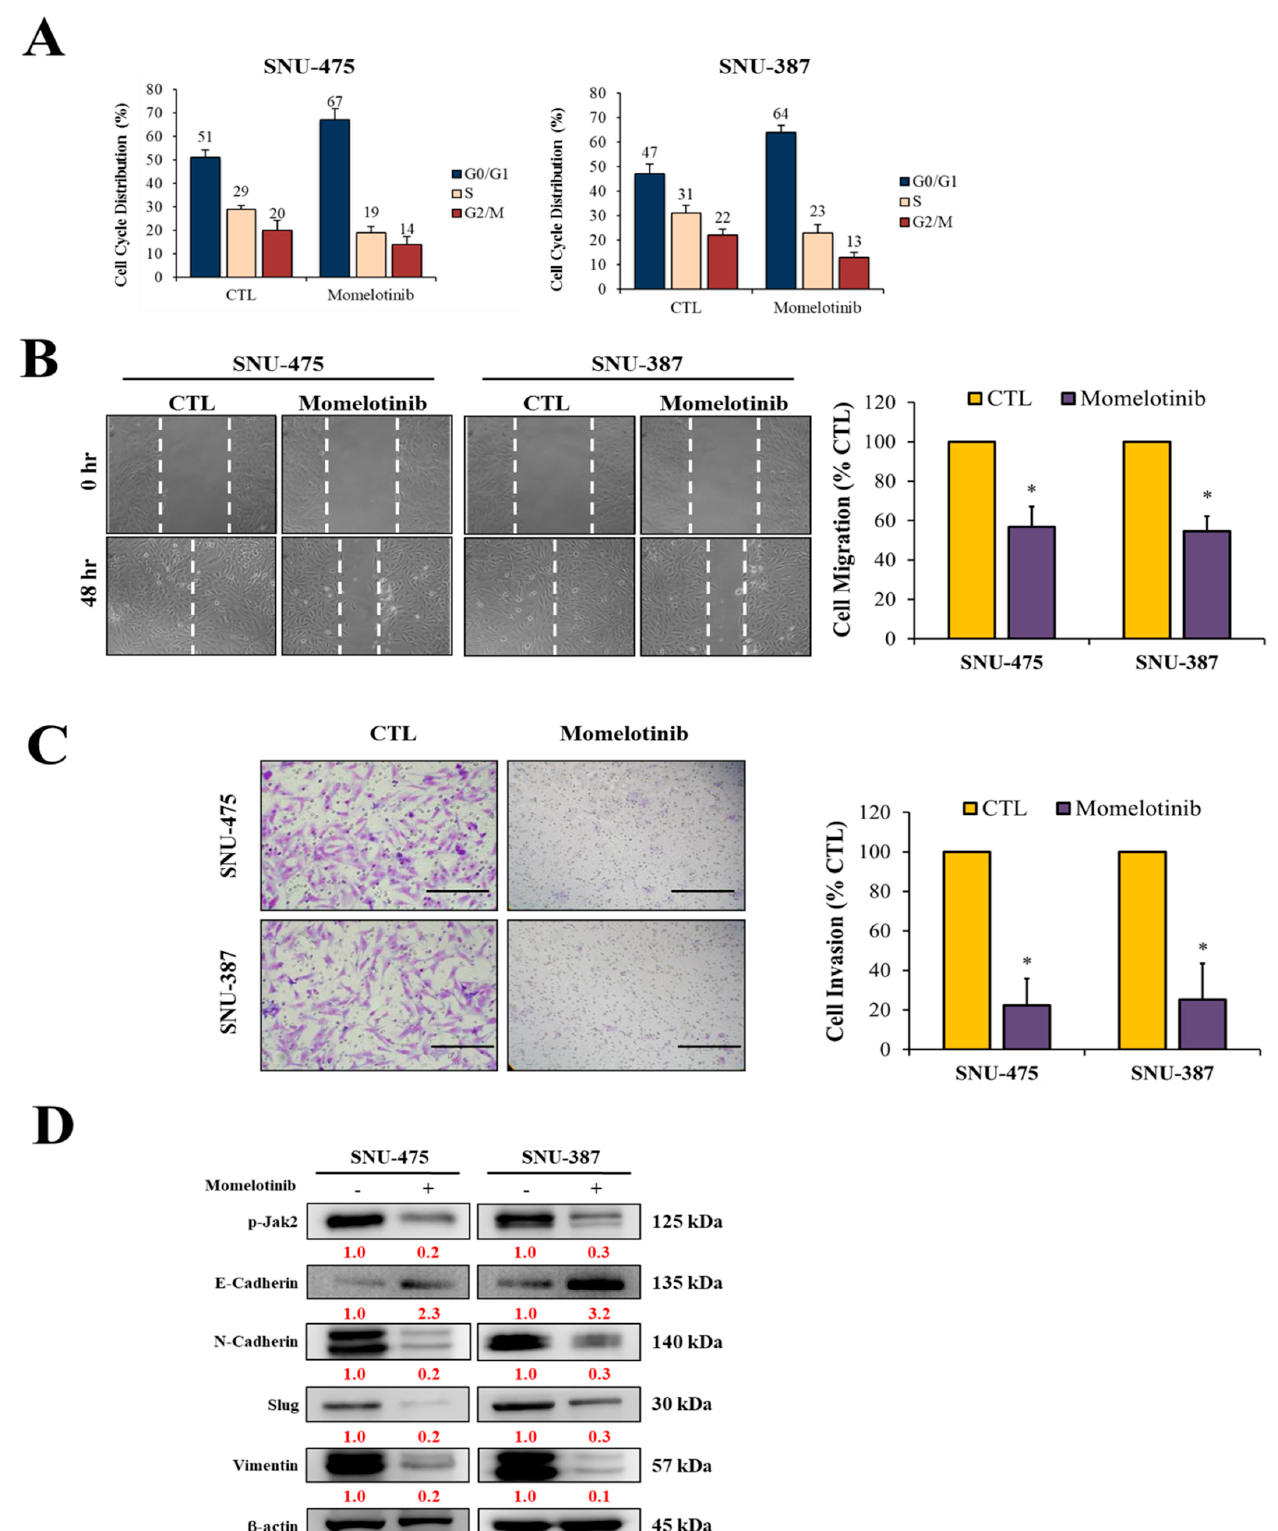
Figure 3. Momelotinib inhibits the migration, invasion, and induces cell cycle arrest of vHCC cells. Representative images of ( A ) momelotinib-induced cell cycle arrest, ( B ) migration, and ( C ) invasion of SNU-457 and SNU-387 cell lines. ( D ) Expression of EMT markers under treatment with momelotinib. The momelotinib treatment dose and time with 5 µM and 48h. β -actin was used as a loading control. * p < 0.05. Scale bar: 50 µm.